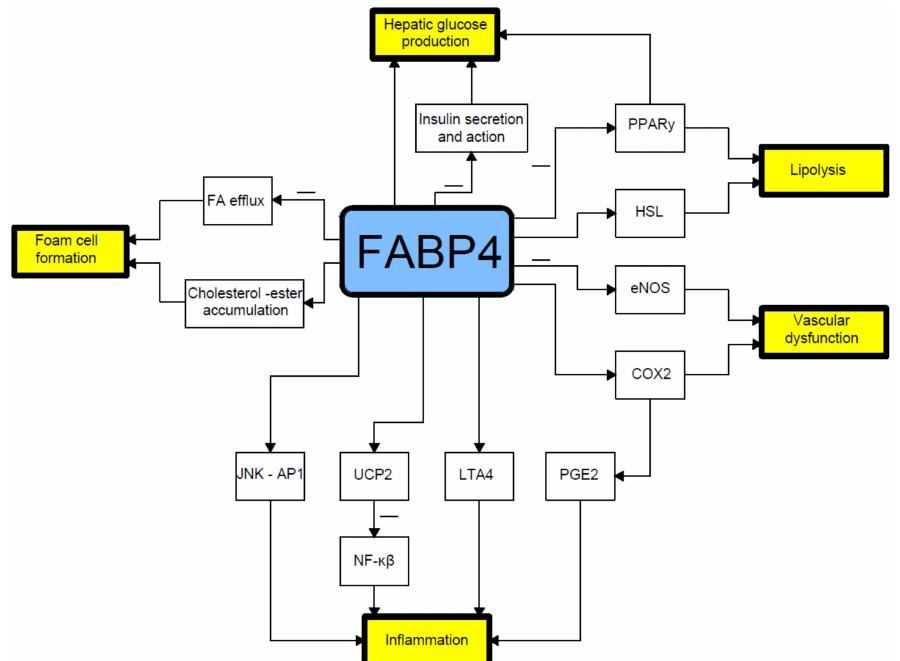
Figure 1. Relationship between fatty acid-binding protein 4 and pathophysiology of type 2 diabetes mellitus. COX2- cyclooxygenase-2; eNOS- endothelial nitric oxide synthase; FA- fatty acid; HSL- hormone sensitive lipase; JNK AP1-Jun N-terminal kinase-activator protein 1; LTA4-leukotriene A4; NF- κ B-nuclear factor-kappa B; PGE2-prostaglandin E2; PPAR γ –peroxisome proliferator-activated receptor γ ; UCP2-uncoupling protein